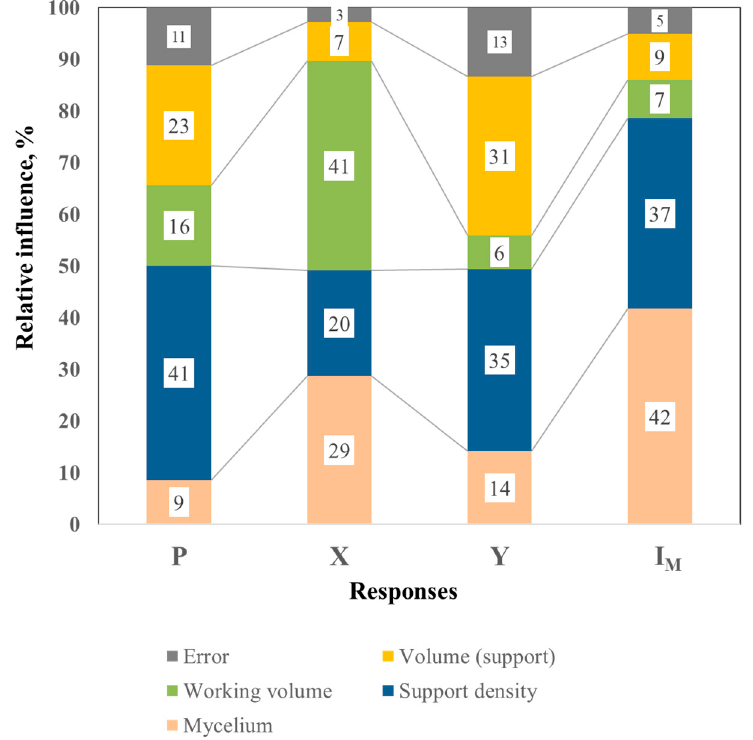
Figure 3. Relative influence percentage of the factors over the responses pigment production (P), biomass (X), pigment per biomass (Y) and immobilization capacity (I M ).